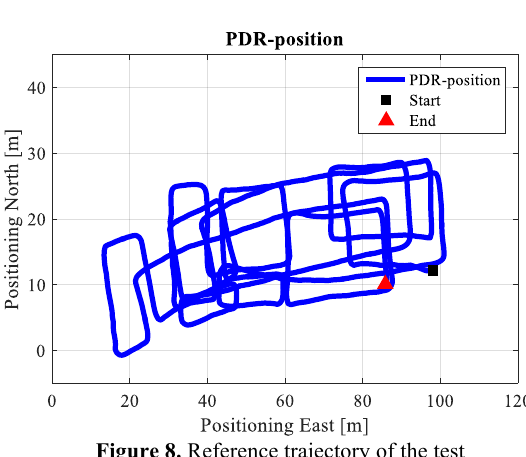
Figure 7. Reference trajectory of the test